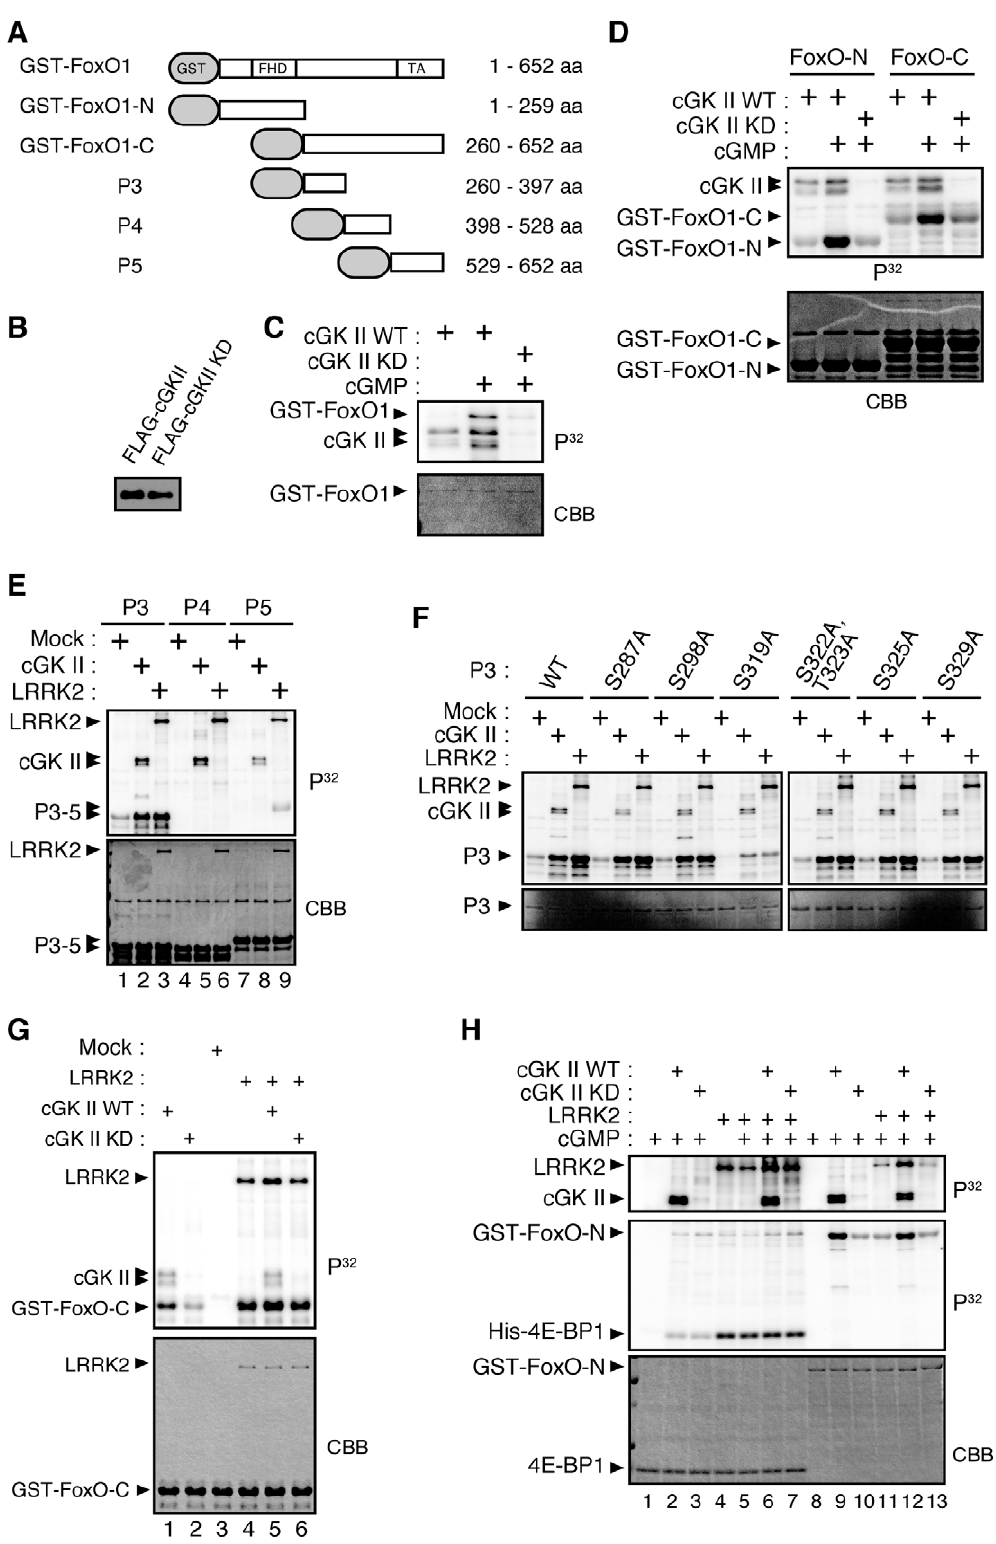
Figure 5. cGKII phosphorylates FoxO1 invitro . ( A ) The recombinant FoxO1 proteins used as substrates. GST, GST-tag. Numbers indicate corresponding amino acid residues of FoxO1. ( B ) FLAG-tagged cGKII and FLAG-cGKII KD were immunoprecipitated from FLAG-tagged cGKII or FLAG- cGKII KD-transfected 293T cells as kinase sources. Western blotting confirmed that the amounts of the two proteins obtained were similar. ( C, D ) In vitro kinase assays of cGKII using recombinant GST-FoxO1 as a substrate. In the presence of cGMP, cGKII WT but not cGKII KD phosphorylated GST- FoxO, GST-FoxO-N, and GST-FoxO-C. Autoradiography (P 32 ) and Coomassie brilliant blue (CBB) staining of the gels are shown. Note cGKII proteins by